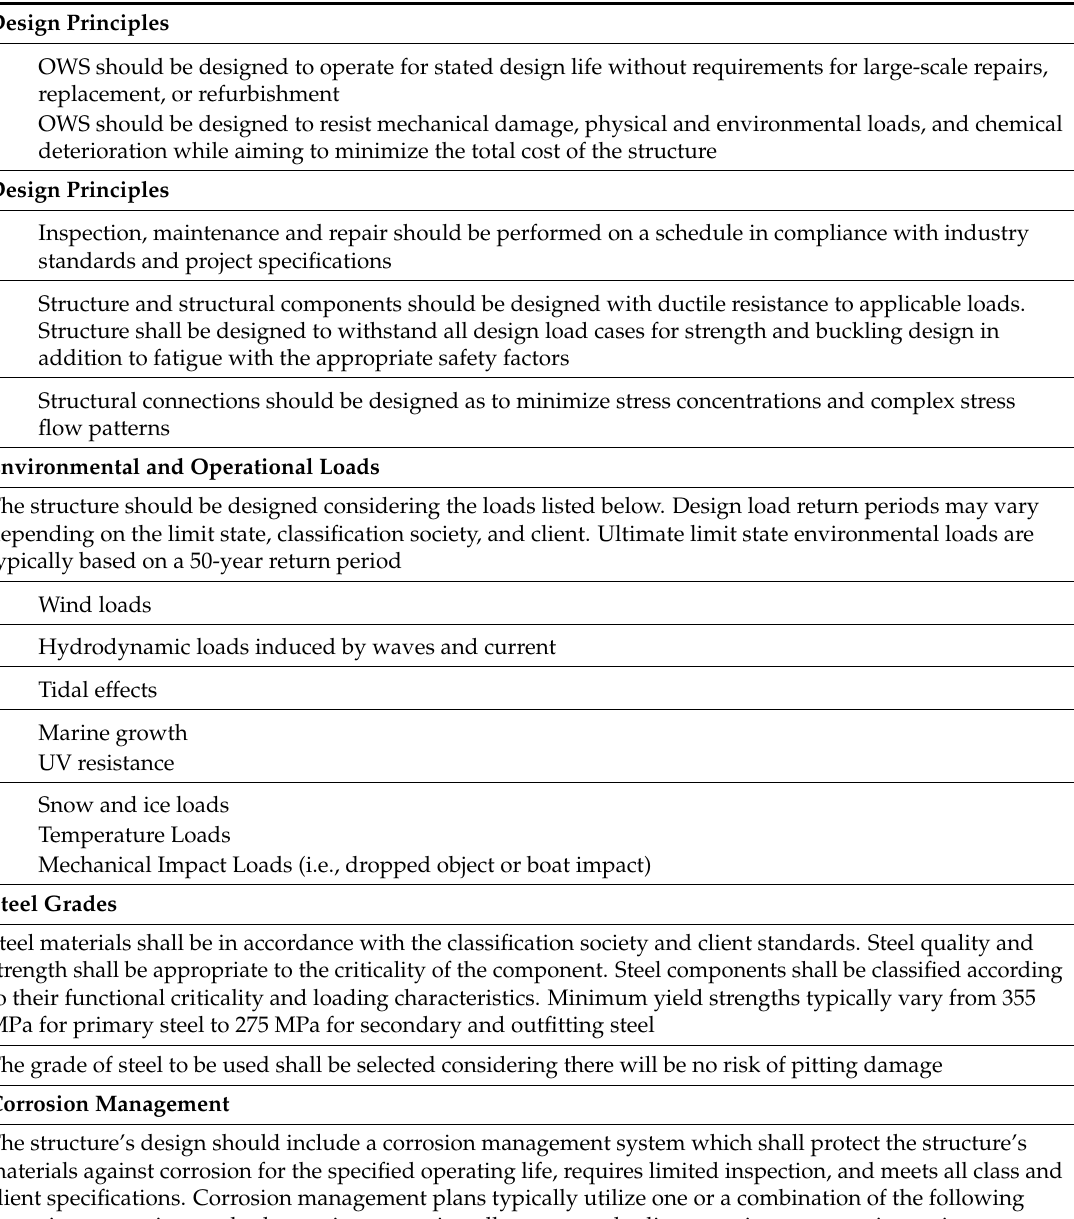
Table 2. Typical Requirements for offshore wind power structures (OWSs)